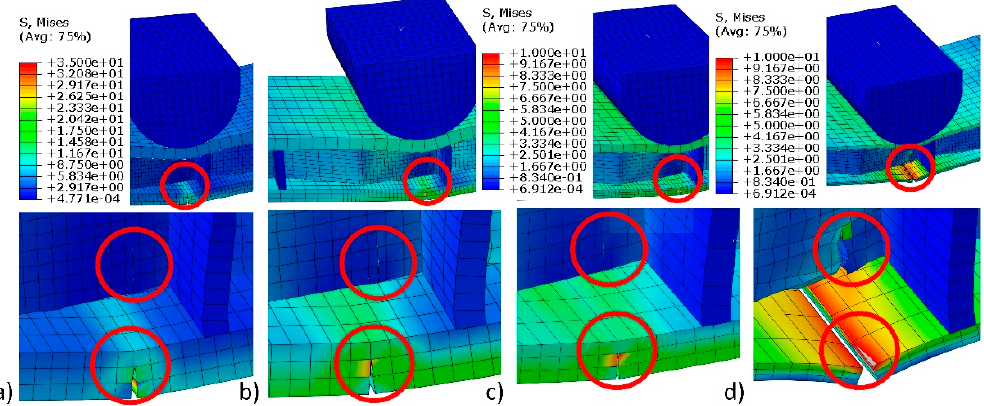
Figure 11. Examples of the cracks in the facings and core of multilayer beams: ( a ) PL(L), ( b ) PL(R), ( c ) HDF, and ( d ) CA.